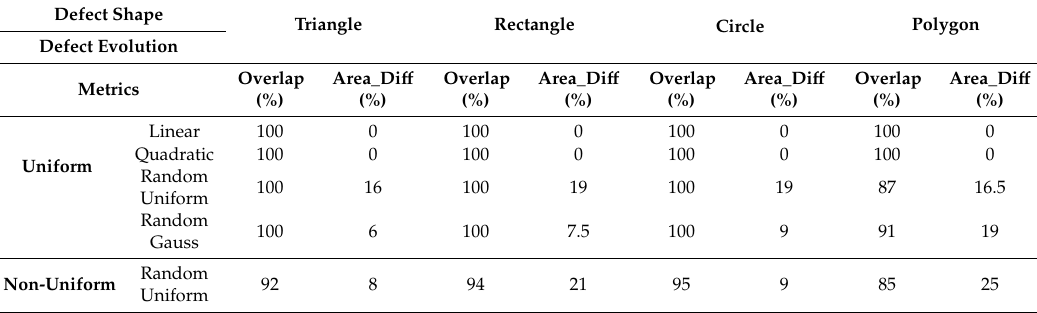
Table 3. Comparison of predicted defect shape using VAR model against ground